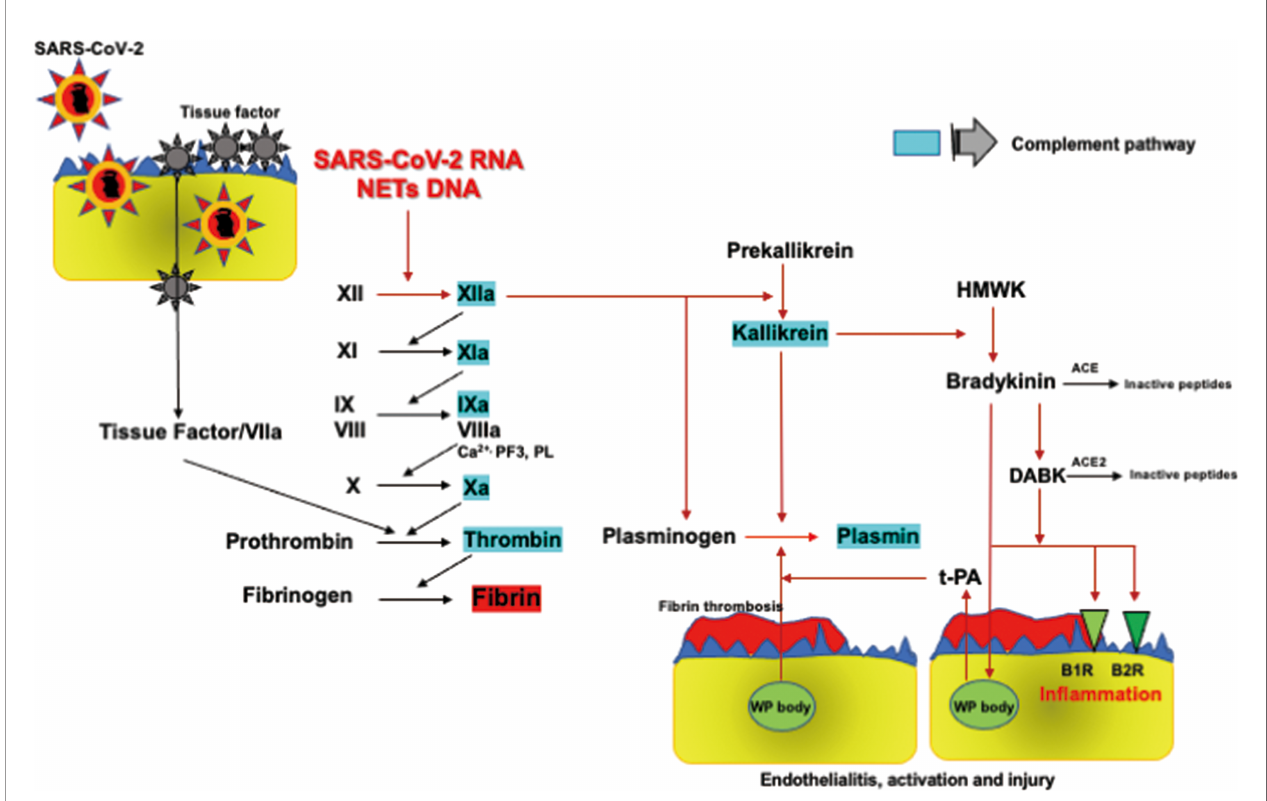
FIGURE 3 | FXII-dependent contact activation system and KKS. SARS-CoV-2 RNA and NETs-containing DNA activate the FXII-dependent contact system, initiating both the contact coagulation pathway and KKS. FXIIa and kallikrein directly activate plasminogen to generate plasmin. Kallikrein cleaves HMWK to bradykinin, which is metabolized into DABK. Bradykinin and DABK induce in fl ammation producing in fl ammatory cytokines through KB1R and KB2R. Bradykinin also induces fi brinolysis through t-PA release from Weibel-Palade bodies in endothelial cells via KB2R, leading to plasmin formation. Therefore, bradykinin as well as FXIIa and kallikrein play central roles in in fl ammation and plasmin-induced fi brinolysis in COVID-19. ACE, angiotensin-converting enzyme; KB1R, kinin B1 receptor; KB2R, kinin B2 receptor; DABK, des-Arg 9 -bradykinin; HMWK, high molecular weight kininogen; KKS, kallikrein and kinin system; NETs, neutrophil extracellular traps; SARS- CoV2, severe acute respiratory syndrome coronavirus 2; t-PA, tissue-type plasminogen activator; WP body, Weibel-Palade body. Factors highlighted in blue activate complement pathways as shown in Figure 4